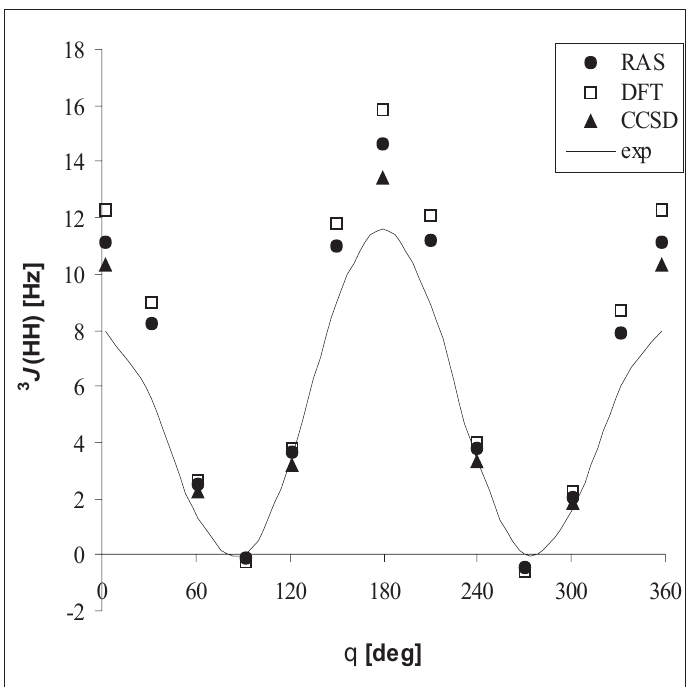
Figure 2: Comparison of the Karplus curve for methylamine obtained at the DFT level the MCSCF level (RAS-0 results from Ref. [22]) and the CCSD level with an empirical curve